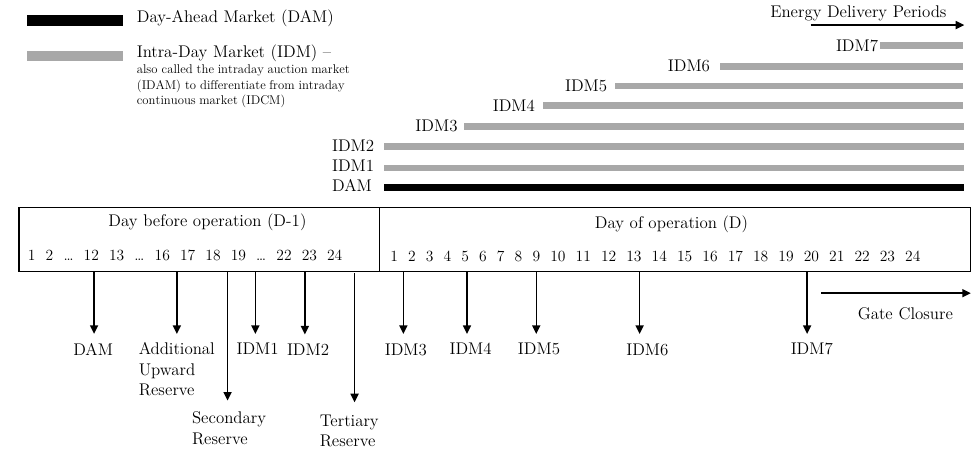
Figure 1. Sequence of the Spanish electricity